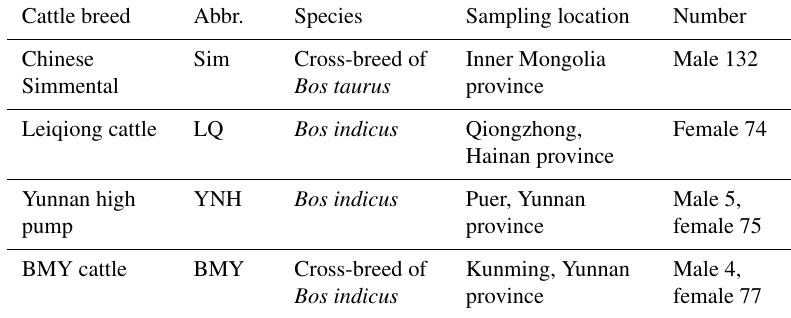
Table 1. The details of four Chinese cattle